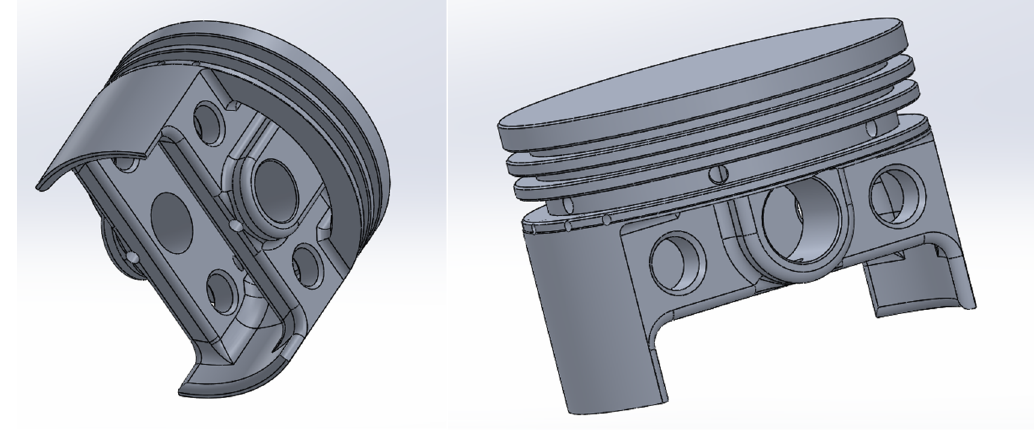
Figure 14. Piston models in Solidworks.